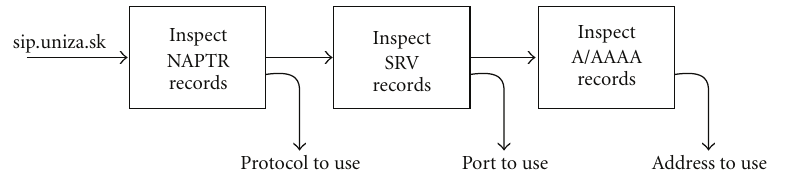
Figure 3: How SIP endpoint locates right servers.